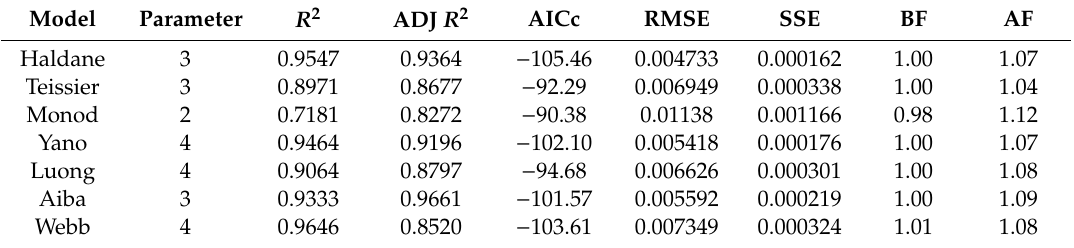
Table 1. Statistical analyses of waste canola oil growth kinetics models.